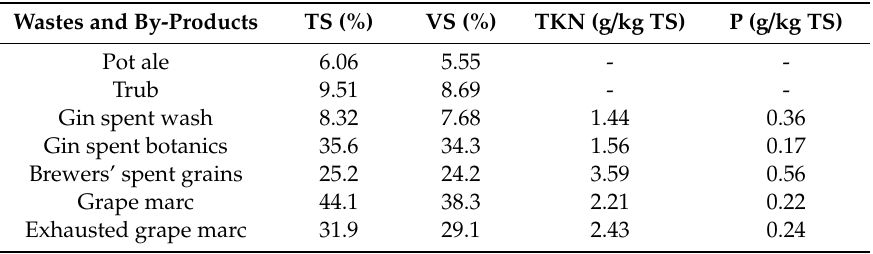
Table 1. Characteristics of wastes and by-products analyzed in the study (TS and VS are expressed as a percentage of the total mass).